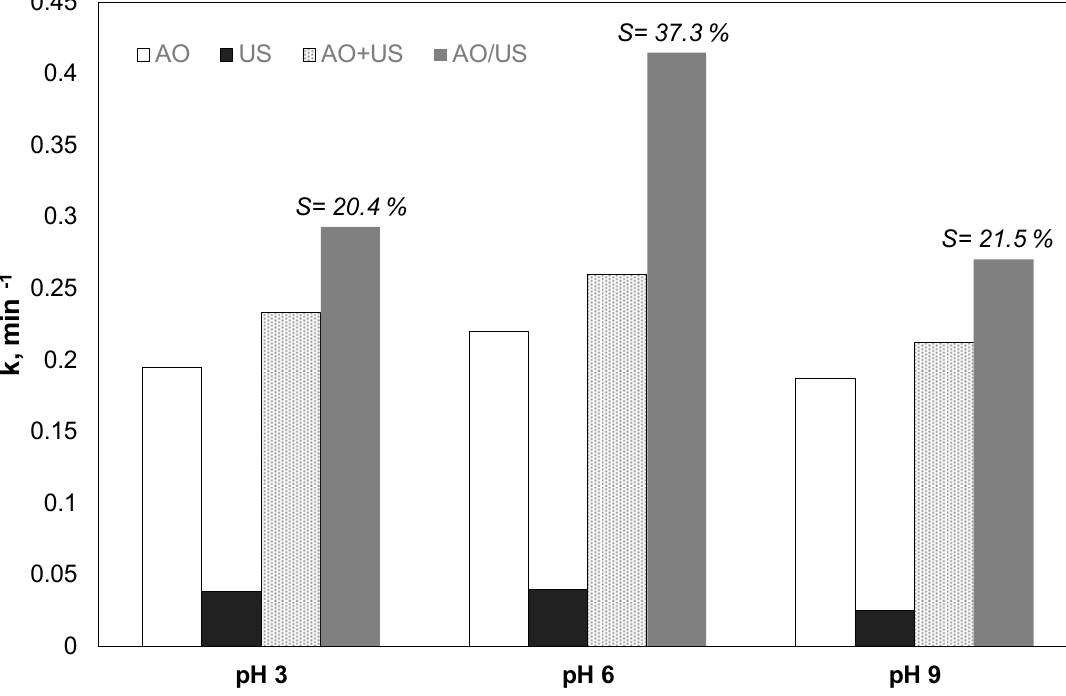
Figure 3. E ff ect of pH on the kinetic constant for the degradation of 0.5 mg / L paraben by electrochemical anodic oxidation (AO), ultrasound (US), theoretical sum (AO + US) and combined (AO / US) process [Na 2 SO 4 ] = 0.1 M, 3.75 mA / cm 2 , 36 W / L at 20 kHz.